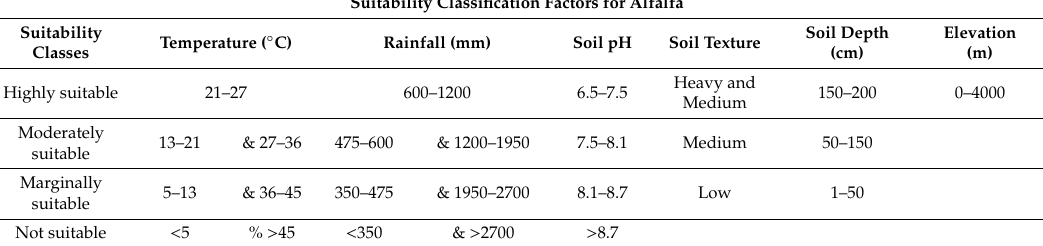
Table 3. Land Suitability classification factors for alfalfa. Suitability classes were derived from climate, soil, and elevation requirements for optimal and absolute growth conditions for the specie and defined by ecocrop